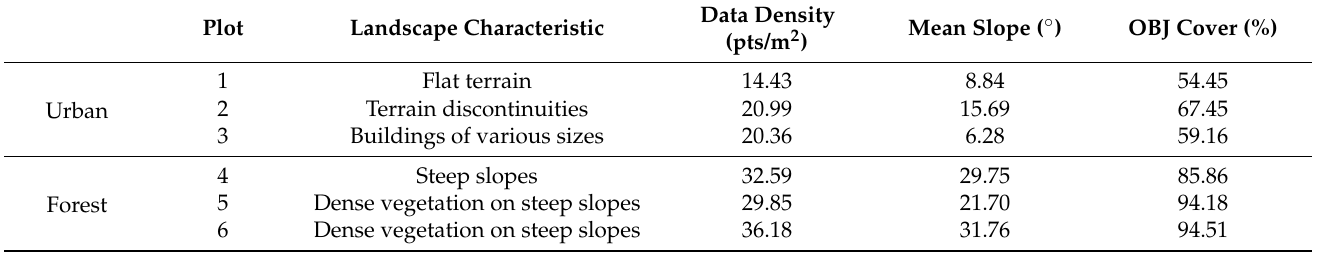
Table 2. Landscape characteristics and some statistical information of the six datasets including data density, mean slope and OBJ cover.